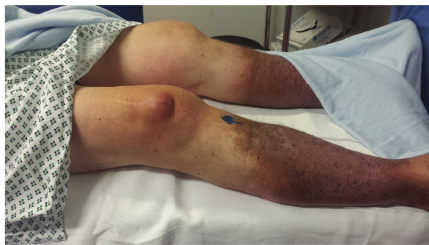
Figure 3: Postoperative AP and lateral radiographs of the right knee showing that the patellar button has migrated anteriorly to the patella.